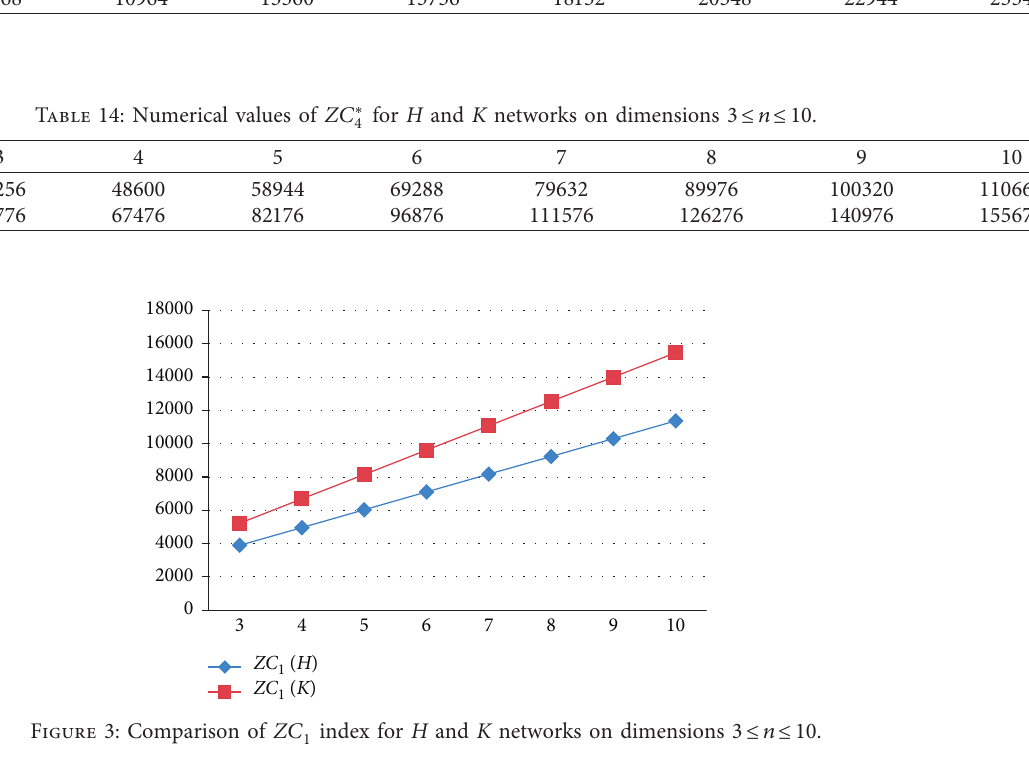
index for H and K networks on dimensions 3 ≤ n ≤ 1